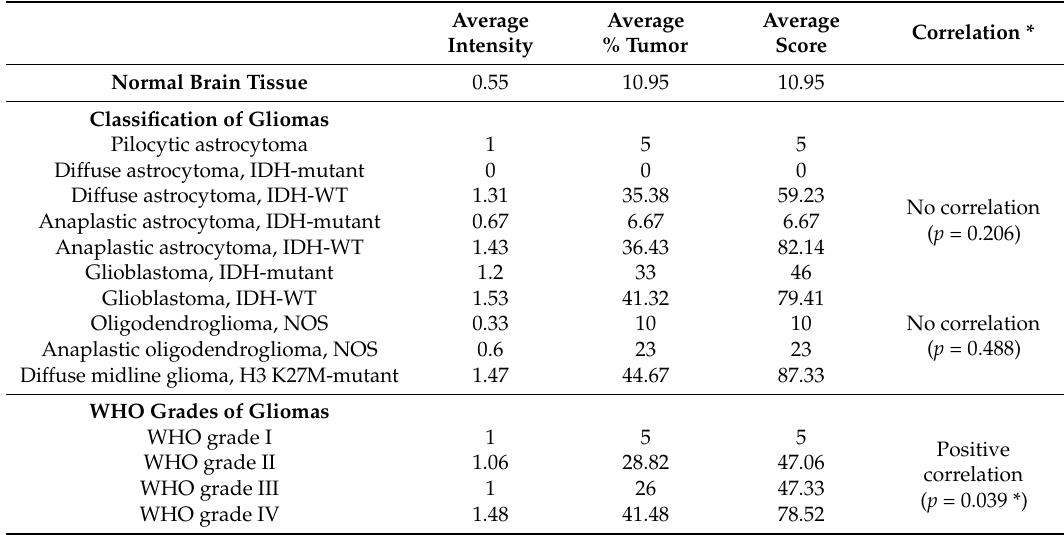
Figure 2. Using quantitative RT-PCR to detect PLP2 mRNA expression in GBM8401, LN229, U87, and U118MG glioma cell lines and normal brain tissue cDNA. β -actin served as a loading control. Data are representative of three independent experiments. (* p < 0.05; ** p < 0.01; *** p < 0.001). Table 1. The correlation of PLP2 immunostain score with WHO grades of